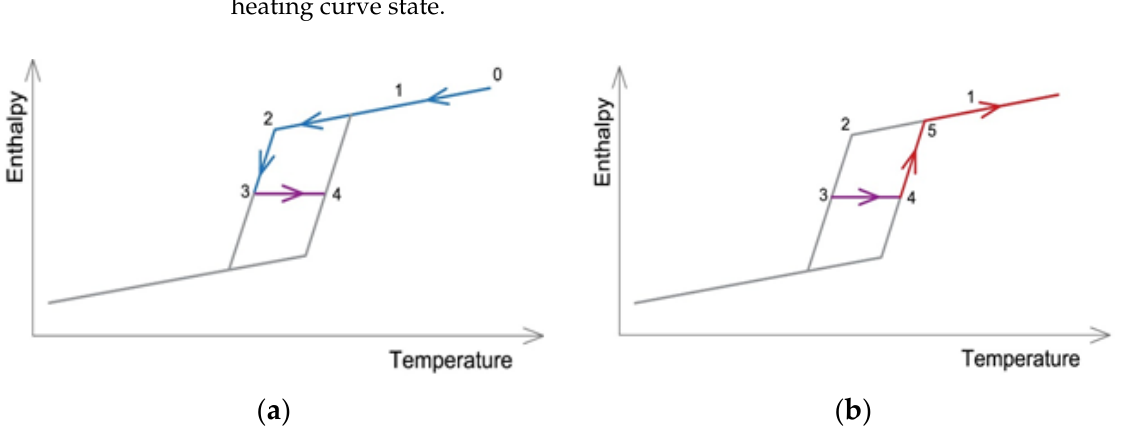
Figure 5. Intermediate transition curve between solidification ( a ) and melting ( b ) curves [26].